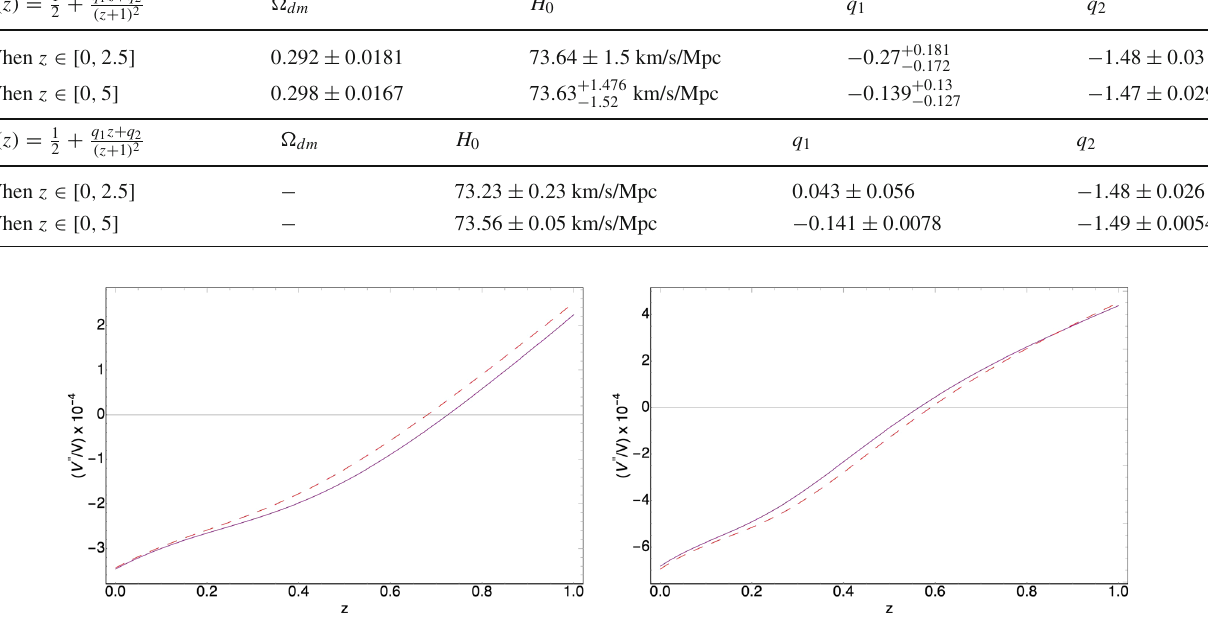
Fig. 5 A graphical behavior of the SC2, Eq. (3), for the first model given Eq. (14) is depicted on the left hand side plot. On the right hand side plot, the behavior of the SC2, Eq. (3), for the second model given Eq. (16) is represented. In all cases, the purple curve is the plot for